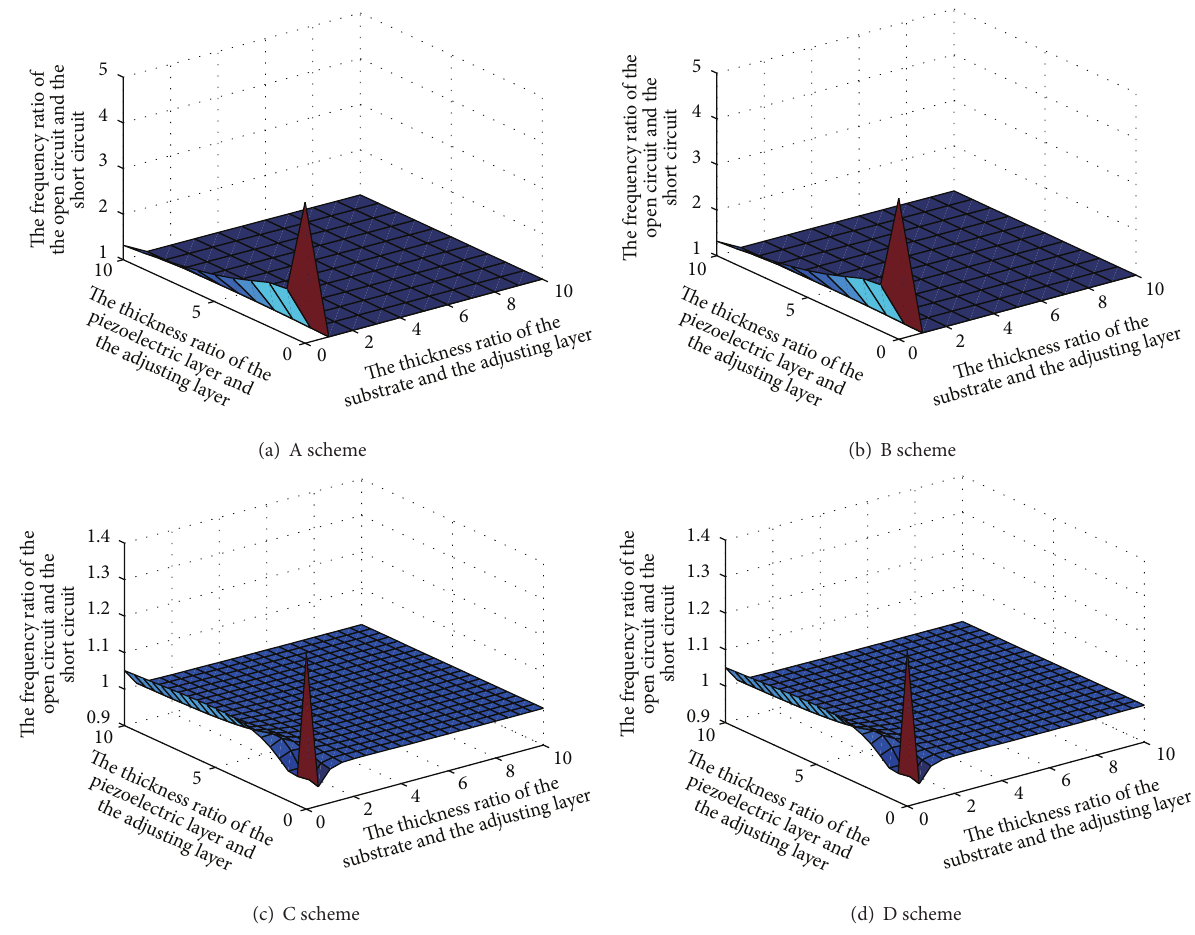
Figure 7: Natural frequency ratio versus thickness